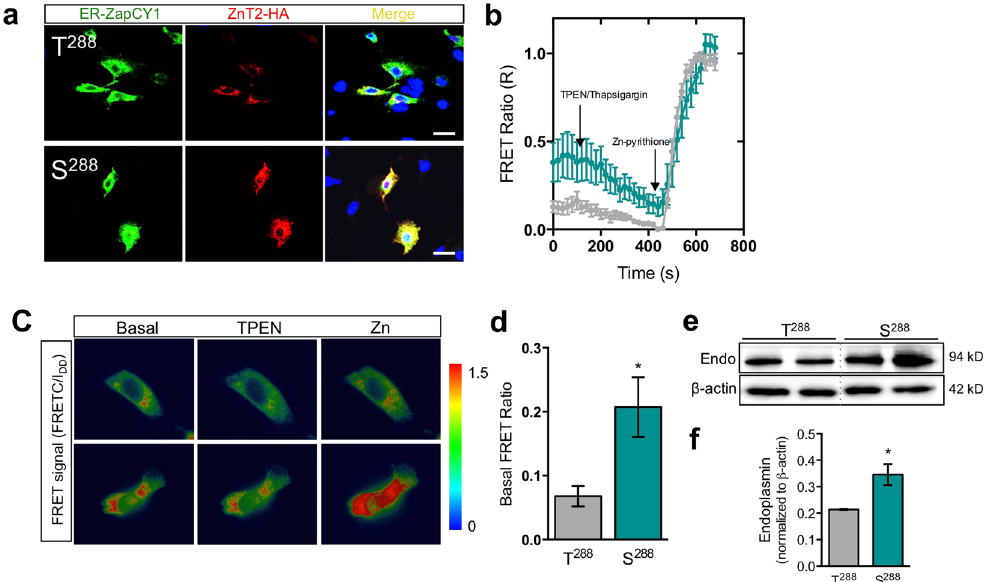
Figure 2. Ectopic expression of the S 288 variant of ZnT2 is retained in the ER, accumulates Zn in ER, and induces ER stress. ( a ) Representative confocal images of ER-ZAPCY1 (green) and ZnT2-HA (red) in MECs transfected to express wild-type ZnT2 (T 288 ) and the ZnT2 variant (S 288 ). Merged images (yellow) illustrate co-localization of ER-ZAPCY1 and ZnT2. Nuclei were counterstained with DAPI (blue). Note robust co-localization of ER-ZAPCY1 and ZnT2-HA in MECs expressing S 288 (Pearson’s coefficient = 0.87), indicating ER localization of S 288 compared with MECs expressing T 288 (Pearson’s coefficient = 0.34; scale bar, 25 µ m). ( b ) Representative FRET analysis demonstrating the changes in FRET ratio (R) of ER-ZAPCY1 in MECs expressing T 288 or S 288 treated with TPEN (100 µ M) and thapsigargin (2 µ M; R min ) followed by zinc pyrithione (100 µ M; R max ), n = 10–14 cells/genotype, from four independent experiments. ( c ) Representative pseudocolored FRET signal images of ER-ZAPCY1 in MECs expressing T 288 or S 288 at rest (Basal), after TPEN (100 µ M) + thapsigargin (2 µ M; TPEN) treatment, in each case followed by zinc pyrithione (100 µ M; Zn) treatment (scale bar, 10 µ m). ( d ) Quantification of basal FRET ratio in MECs expressing T 288 or S 288 . Data represent mean FRET ratio at basal levels ± SEM, n = 10–14 cells/genotype, from four independent experiments; p < 0.05 * . ( e ) Representative immunoblot of endoplasmin (Endo) in total lysates from MECs expressing T 288 or S 288 treated with Zn. β -actin served as a loading control. Dotted lines indicate spliced sections obtained from a single blot; representative samples (n = 2/group) were selected for publication. Spliced blots are displayed and full-length blots can be found in Supplementary Fig. S3a,b. ( f ) Quantification of endoplasmin expression. Data represent mean endoplasmin expression normalized to β -actin ± SD, n = 6 samples/genotype, from three independent experiments; p < 0.05 *